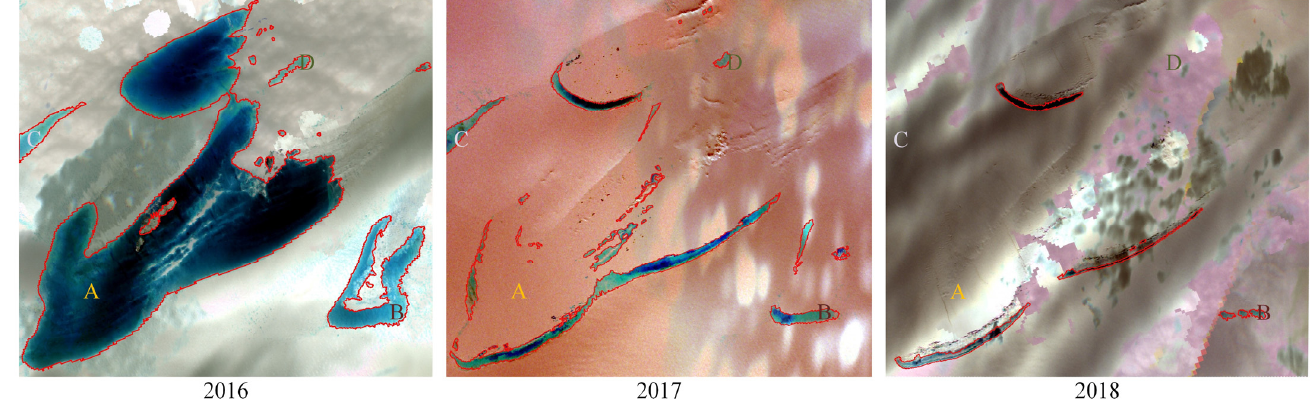
Figure 6. The interannual variability of the maximum lake during the 2016–2018 melt seasons. “A” is the maximum lake, along with its surrounding representative lakes which are labeled with “B”, “C”, “D”. Lakes “A” and “B” split into smaller lakes and mostly disappeared, while lakes “C” and “D” shrank during 2016–2017; lakes “A” and “B” continued to shrink and split, while lakes “C” and “D” disappeared completely during 2017–2018. The background images acquired was the same as those used in Figure 4.